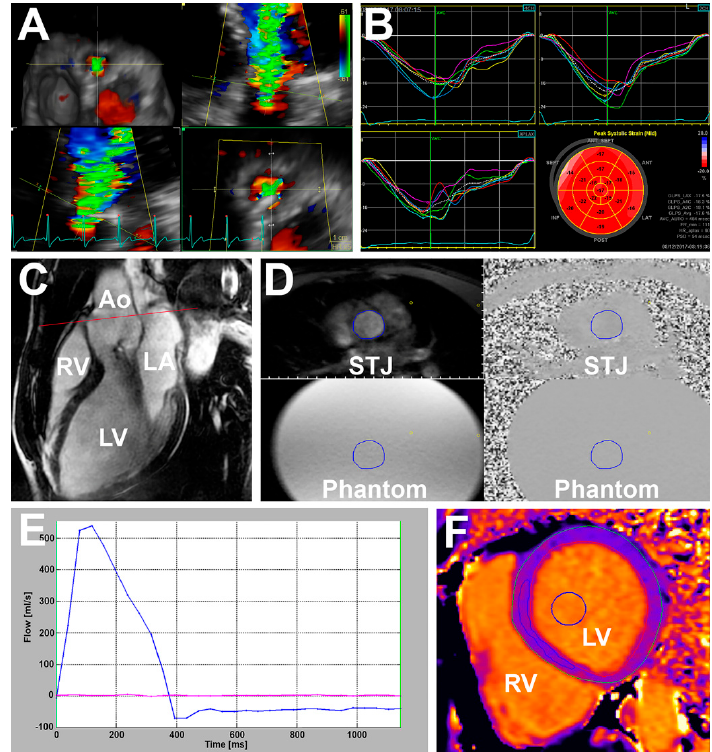
Figure 1. Imaging markers. ( A ) Echocardiography derived three-dimensional vena contracta area; ( B ) echocardiography two-dimensional global longitudinal strain; ( C ) magnetic resonance—the left ventricular outflow tract (cine), red line—through-plane flow sequence slice position displayed on, Ao—aorta, LA—left atrium, LV—left ventricle, RV—right ventricle; ( D ) through-plane flow sequence at sinotubular junction level (STJ) of the aorta (displayed on ( C )), the blue circle is a manually drawn region of interest where the blood flow and regurgitant volume and fraction are calculated. The exact copy of the region interest is in all four images, phantom—stationary phantom used for flow measurement correction; ( E ) flow-time curve based on ( D )—blue line shows blood flow at STJ and red line show flow in stationary phantom; ( F ) native T1 mapping from modified Look–Locker Inversion recovery sequence (MOLLI) sequence, blue circle—a semi-automatically drawn region of interest within the blood pool, blue ellipsoid—a manually drawn region of interest within the myocardium at the level of the interventricular septum utilized for myocardial fibrosis